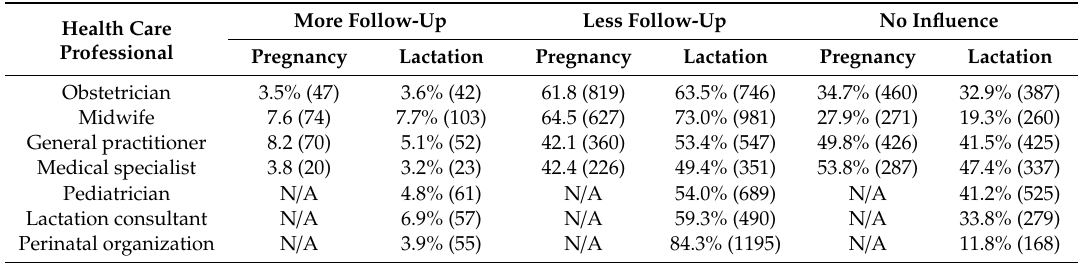
Table 2. Impact of the coronavirus pandemic on the extent of medical counseling during pregnancy and